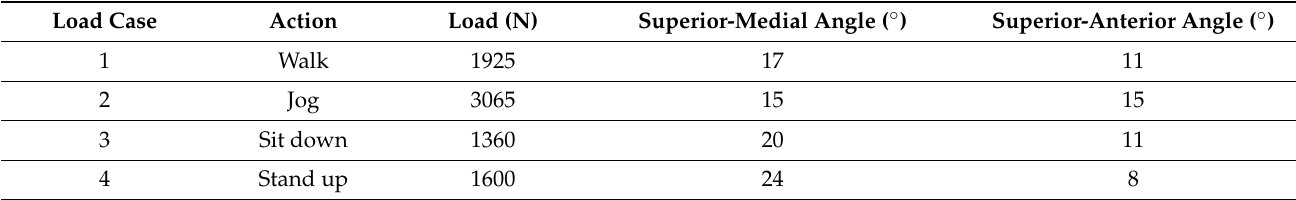
Table 1. Magnitudes and directions of load cases 1–4.